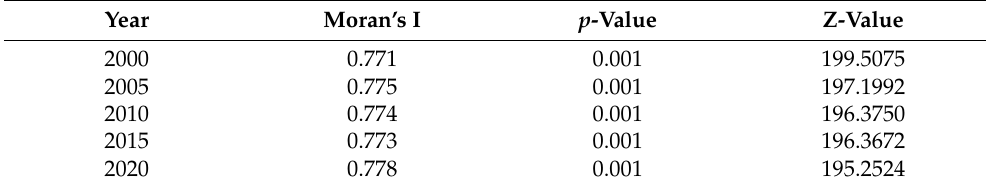
Table 12. Moran’s I index of habitat quality in the Yellow River Basin in 2000, 2005, 2010, 2015,